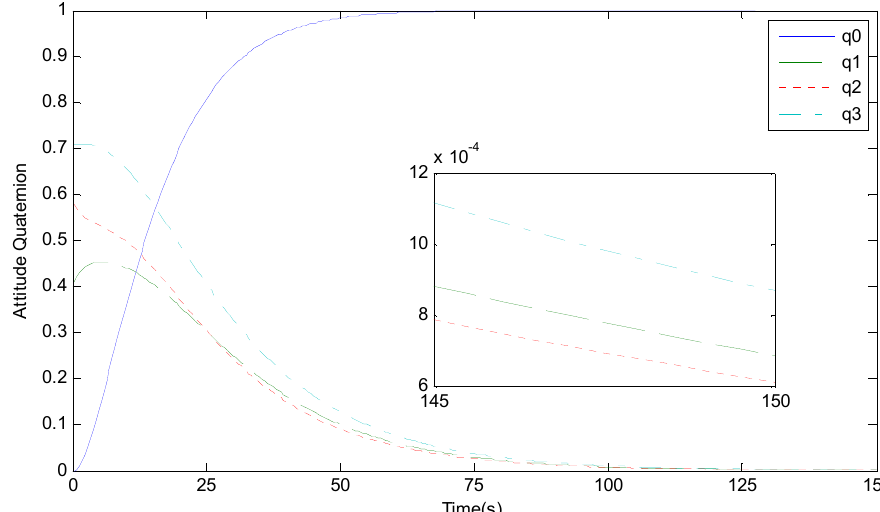
Figure 3. Curve of attitude quaternion.